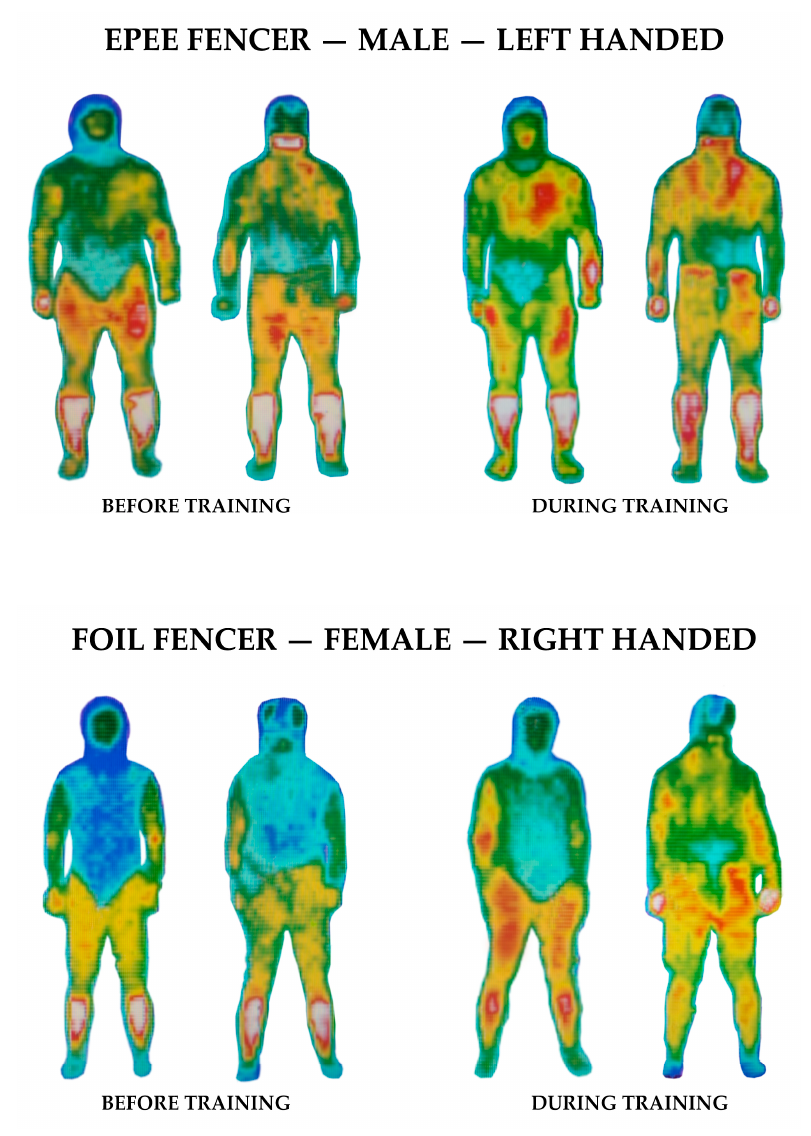
Figure 5. Infrared image of fencers before and during training (image not in scale). From this temperature map, it can be noticed that the dominant part of the body presents an overheating when compared to the non-dominant part.